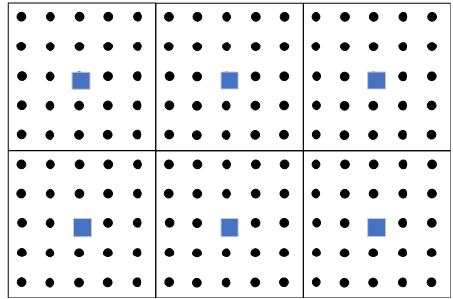
Figure 11. A Distributed WSN Based on Fog Calculation